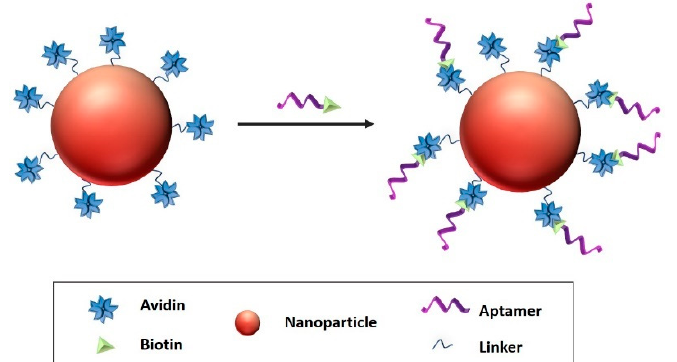
Figure 9. Avidin–biotin coupling, biotin attached the aptamer with avidin linked to the surface of the nanocarrier Reproduced from Odeh, et al. [198].